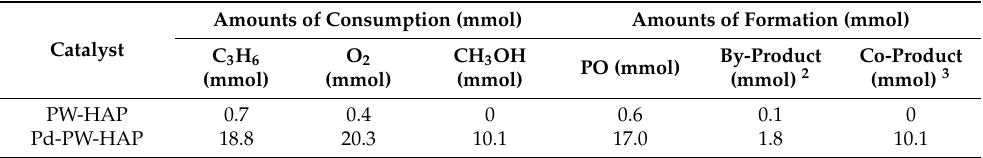
Table 5. Consumed amounts and formed amounts in the propylene epoxidation in methanol over various catalysts at 363 K for 8 h 1 .